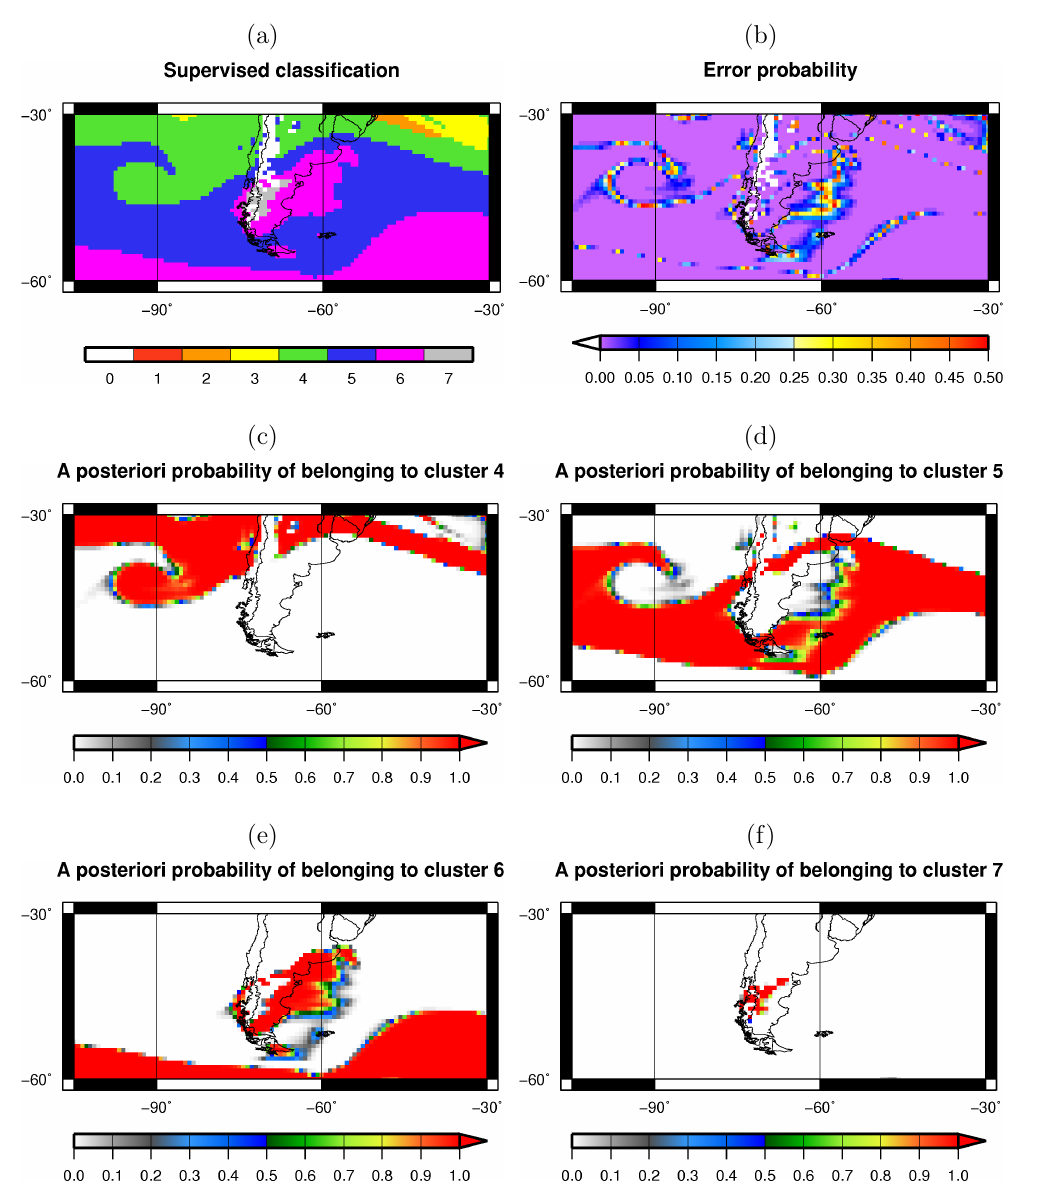
(h) Figure 12. Geographical zoom on 15 July 2006 (00:00UTC). Supervised classification map (a) with the associated error probability (b) and